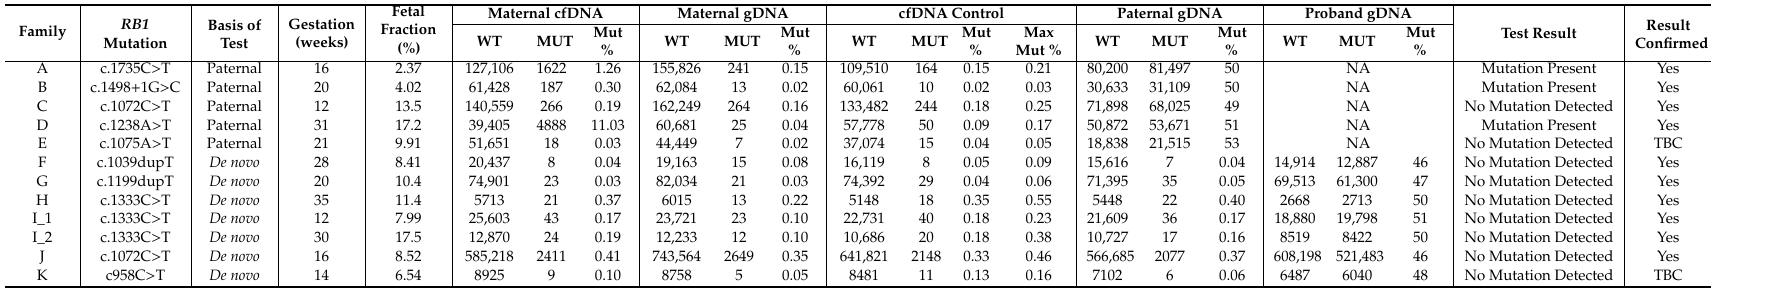
Table 1. Non-invasive prenatal diagnosis (NIPD) results for paternal and de novo RB1 mutations by amplicon-based MPS. Read counts are given for both wild-type (WT) and mutant (MUT) alleles in each sample tested, with the overall percentage of mutant reads (Mut %) also shown. Maternal cfDNA results are the average of two duplicate samples. Cell-free DNA control results are the average reads from five plasma control cfDNA samples. Max mutant % refers to the highest mutant allele % across all five control plasma samples and denotes the background threshold. TBC indicates pregnancies